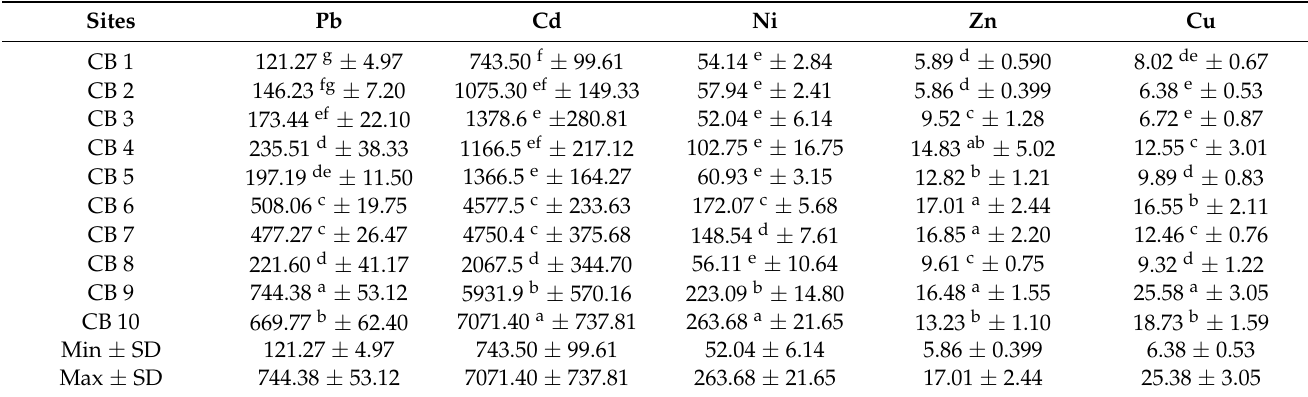
Table 4. Enrichment factor of heavy metals for all sediment samples of Chalan beel area.